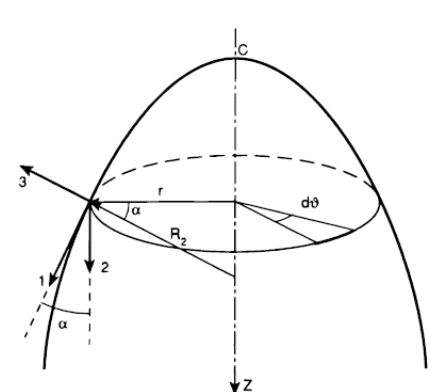
Figure 8: Shell of revolution or thin dome